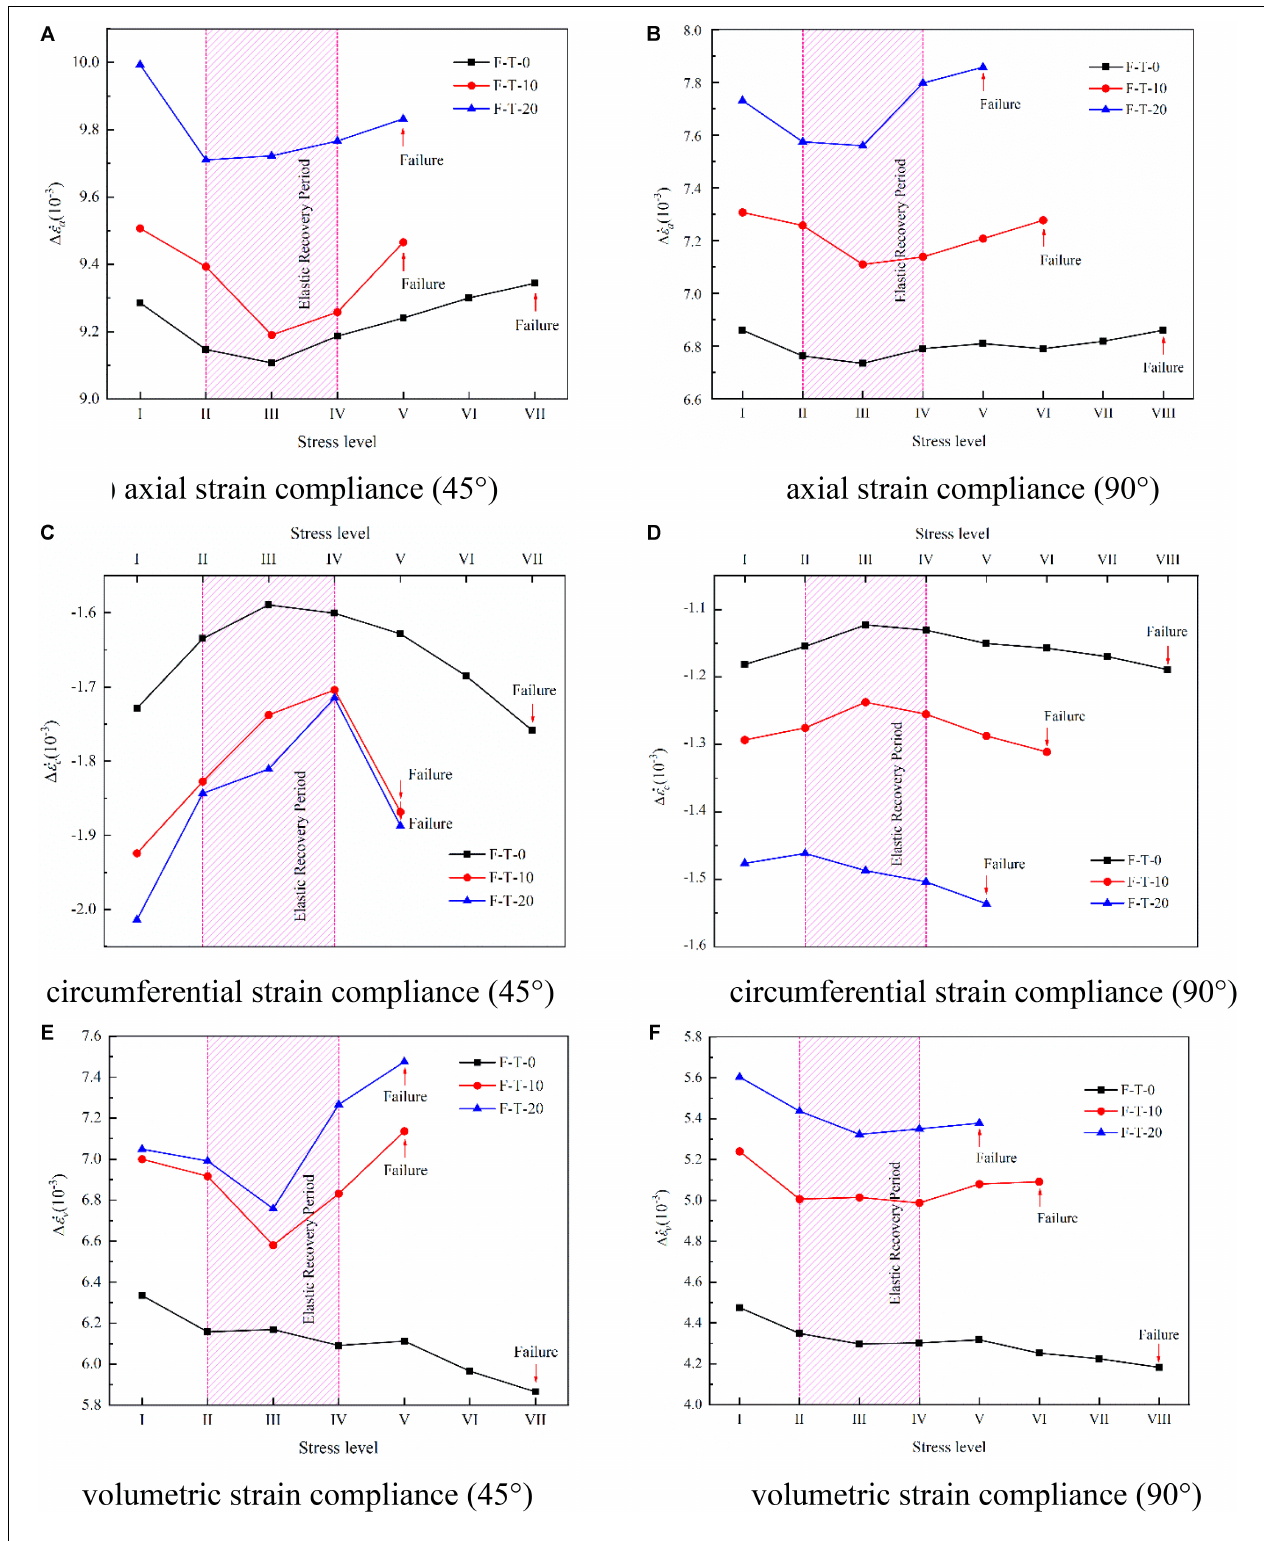
FIGURE 5 | Relationship between the rate of strain compliance and the loading-unloading stress level of fractured sandstones under different F-T cycles.